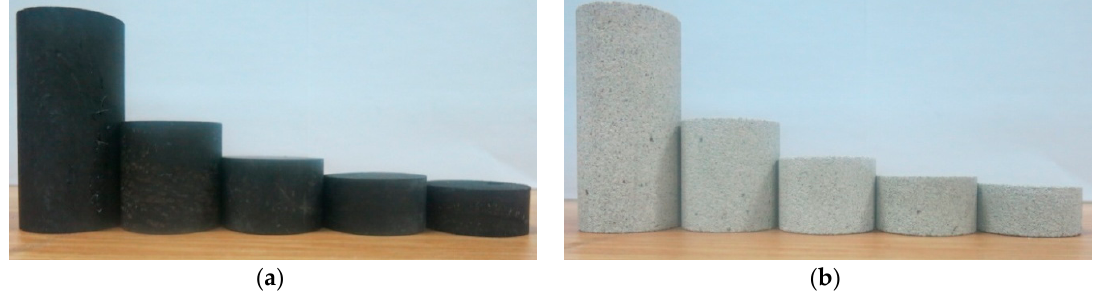
Figure 2. Experimental coal and rock elements. ( a ) Coal element; ( b ) rock element.